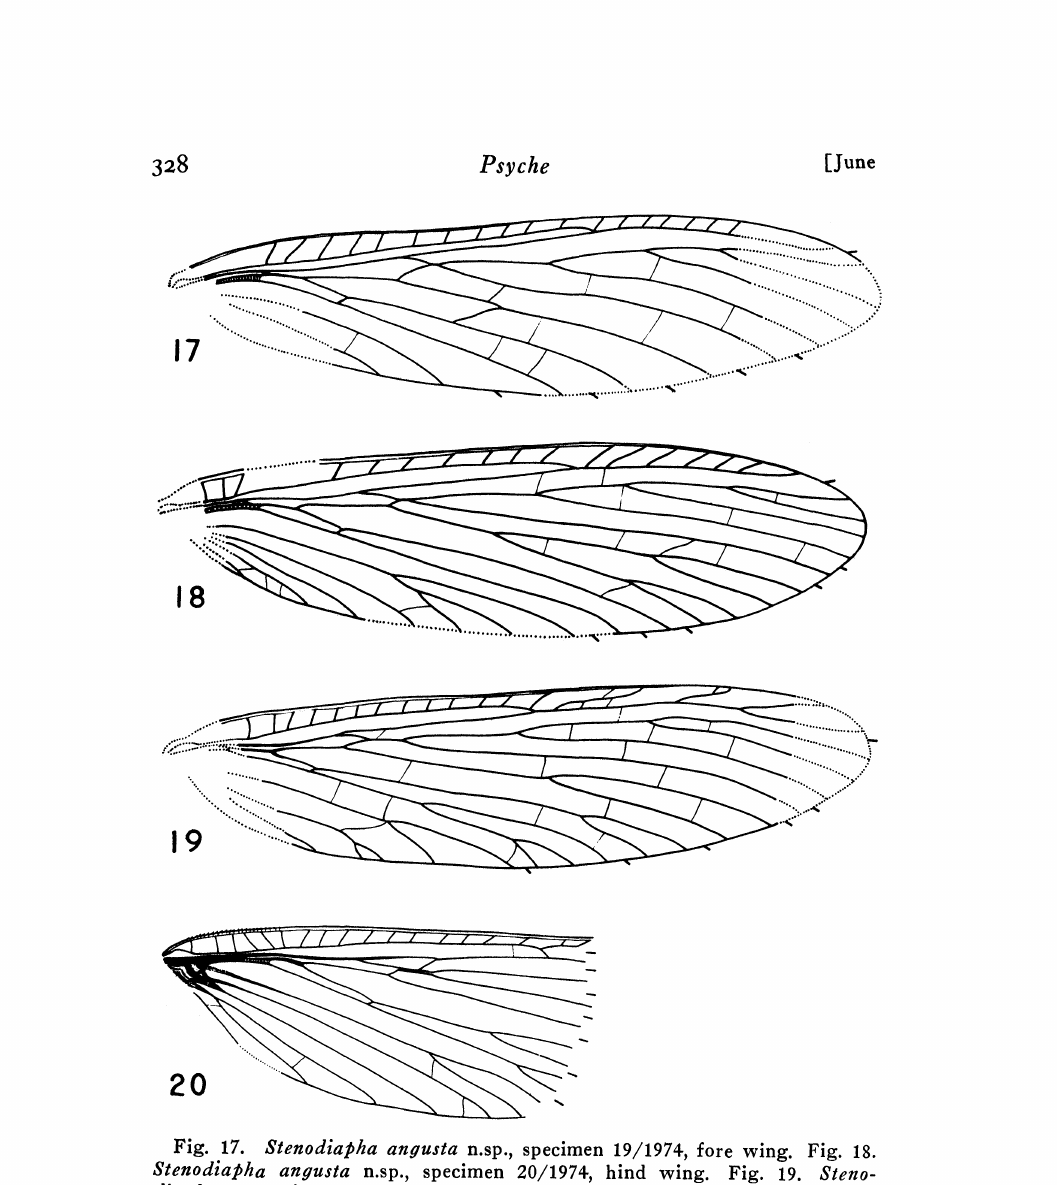
Fig. 17. Stenodiatha angusta n.sp., specimen 19/1974, fore wing. Fig. 18. Stenodia#ha angusta n.sp., specimen 20/1974, hind wing. Fig. 19. Steno- dia#ha moraica n.sp., specimen 21/1974, fore wing. Holotype. Fig. 20. 8tenodia#ha mora,ica n.sp., specimen 22/1974, fore